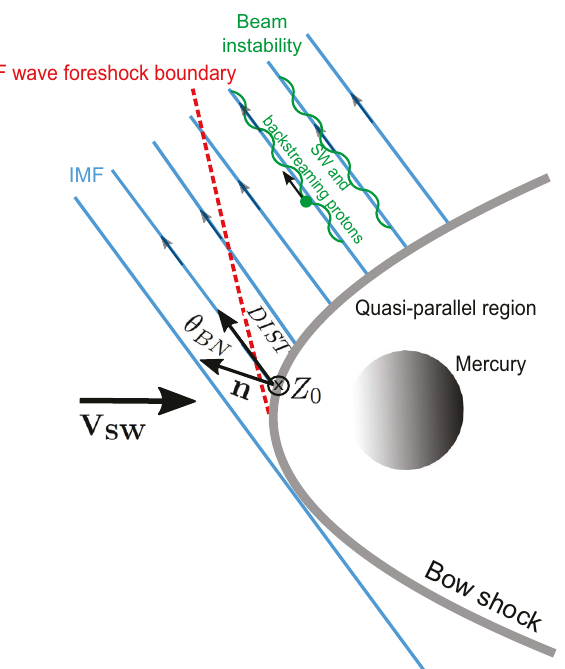
Fig. 1 Illustration of the foreshock. Schematic structure of the planetary foreshock for a given Interplanetary Magnetic Field (IMF) con fi guration. The solar wind (SW) fl ows from left to right with velocity V SW and the bow shock is represented by the curved line. The bow shock structure depends on the angle between the shock normal ( n ) and the magnetic fi eld, θ BN . The quasi-parallel shock is typically de fi ned as the region where θ BN < 45 ∘ . The foreshock, lying upstream of the bow shock and in the region downstream of the IMF tangent fi eld line ( fi rst line from left to right), exhibits a complex structure where several regions and boundaries can be identi fi ed. The Ultra-low frequency (ULF) wave foreshock boundary displays the upstream limit of the ULF wave fi eld inside the foreshock. Such wave fi eld is partly created by plasma instabilities (such as the beam instability) and coexists with backstreaming protons (green dot) interacting with the incoming SW. The foreshock coordinates used on this paper are also shown for reference. DIST measures the distance between the spacecraft and the bow shock location along the IMF direction. Z 0 measures the distance of the spacecraft perpendicular to the SW velocity- IMF plane which contains the center of